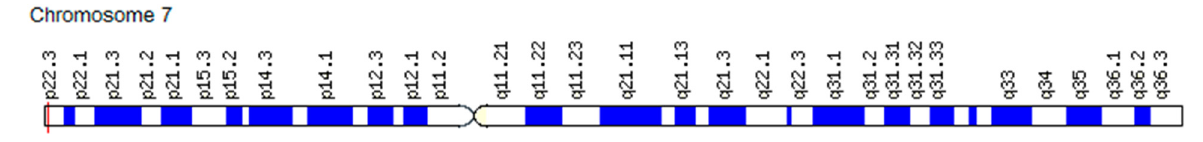
Figure 2. Localization of the PDGFA gene on chromosome 7p22.3. The PDGF-B gene (Platelet-Derived Growth Factor B Chain) is located on chromosome 22q13.1 (Figure 3). This growth factor plays an important role in the regulation of embryonic development, cell proliferation, cell migration, survival, and chemotaxis [106].